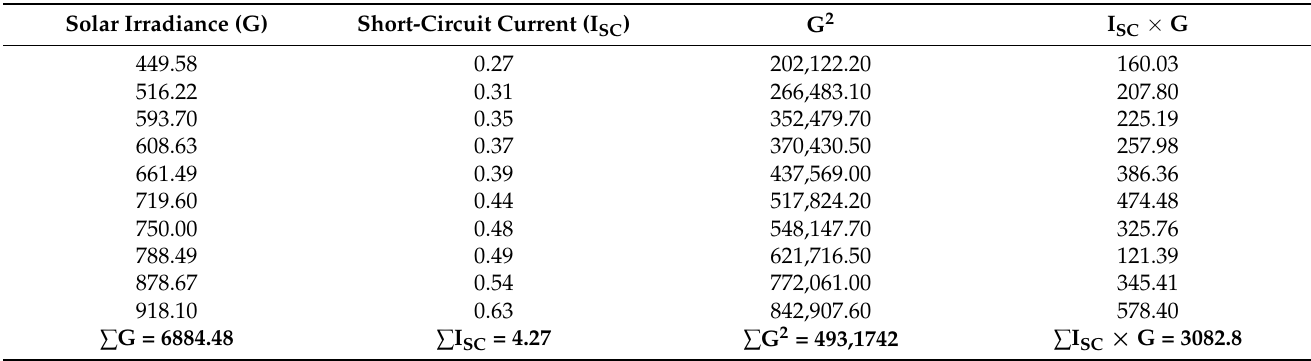
Table 5. Regression Data.